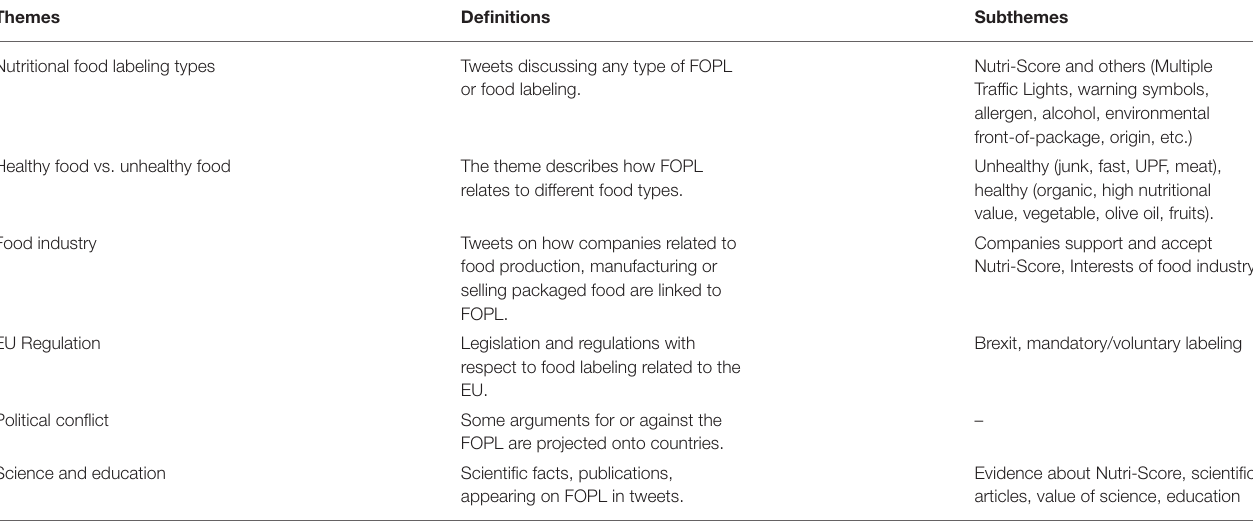
TABLE 1 | Definition of themes and their